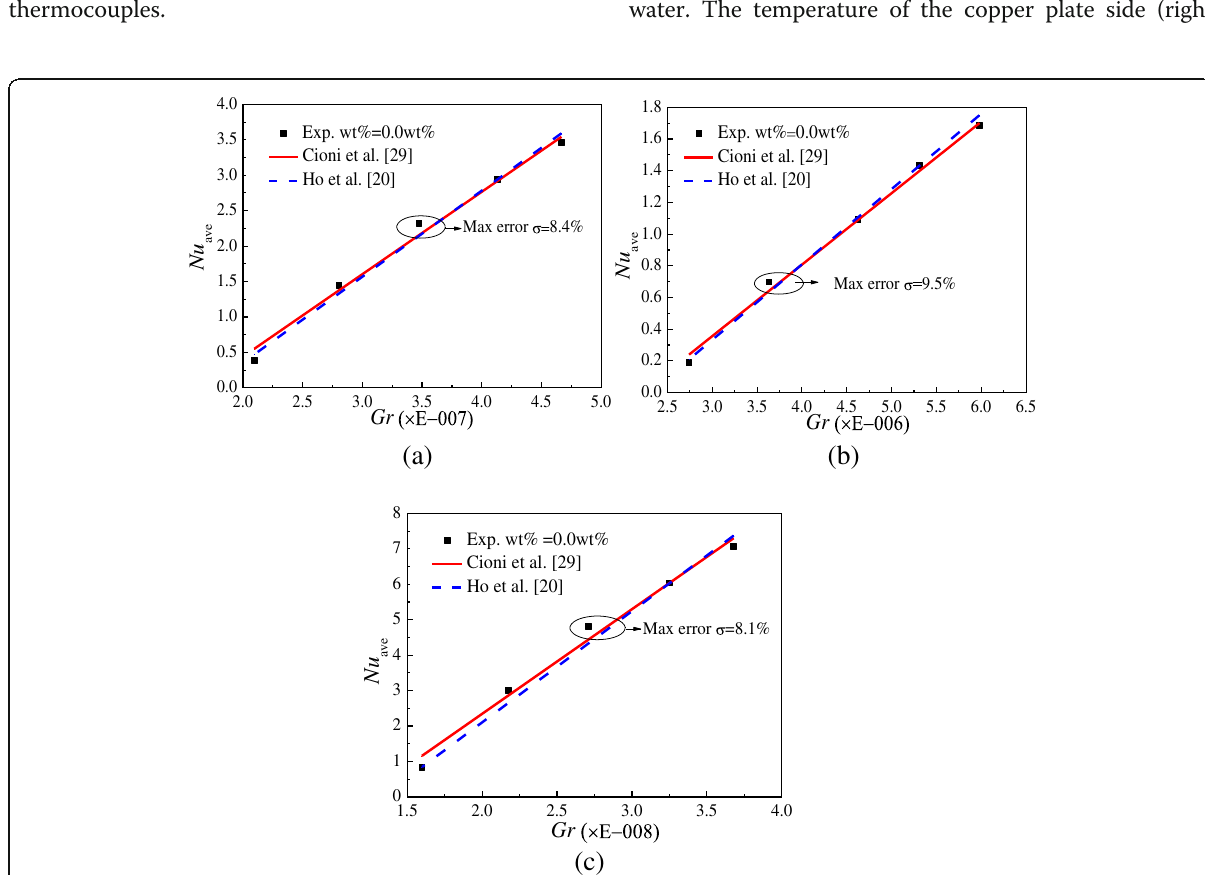
Fig. 7 Experiment set validation. Comparison of Nusselt numbers between the experimental results and the published literatures in enclosures with two different aspect ratios. a A = 1:2. b A = 1:4. c A =